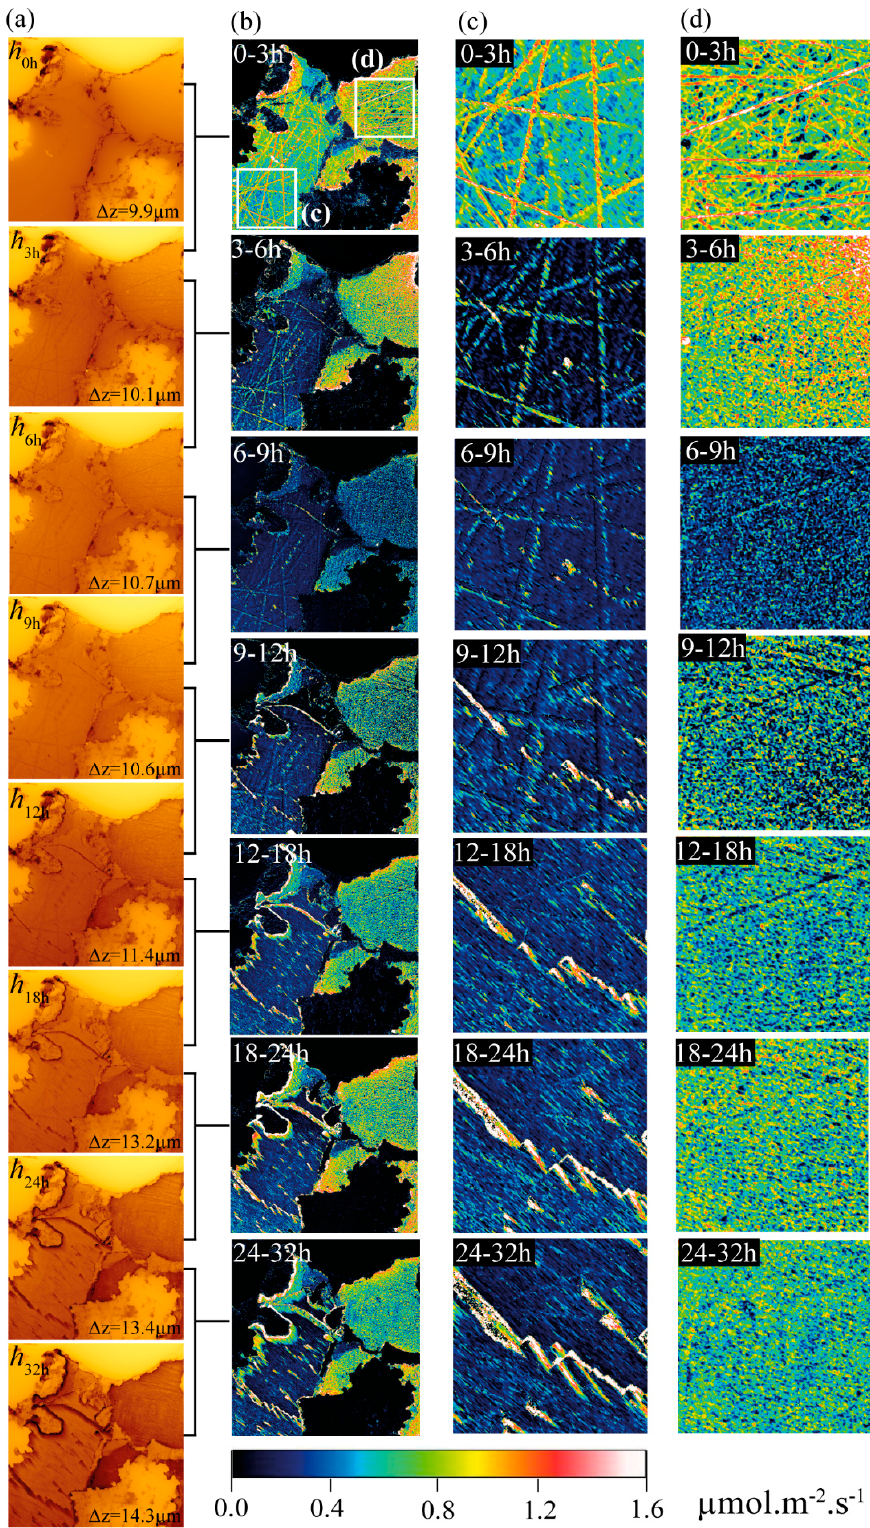
Figure 3. Reaction sequence data of a flow-through experiment using a 2 mmol Na 2 CO 3 solution at room temperature: ( a ) height maps ( h i ) of the sandstone’s surface, darker yellow areas corresponds to deeper areas and brighter yellow to higher areas (278 × 288 µm); ( b ) rate maps ( r i − j ) obtained from the subtraction of the height maps difference; ( c ) and ( d ) are sub-sections (81 × 81 µm) of the rate maps, see location in b, 0–3 h. Values above 1.6 µmol·m − 2 ·s − 1 appear white colored in the maps.